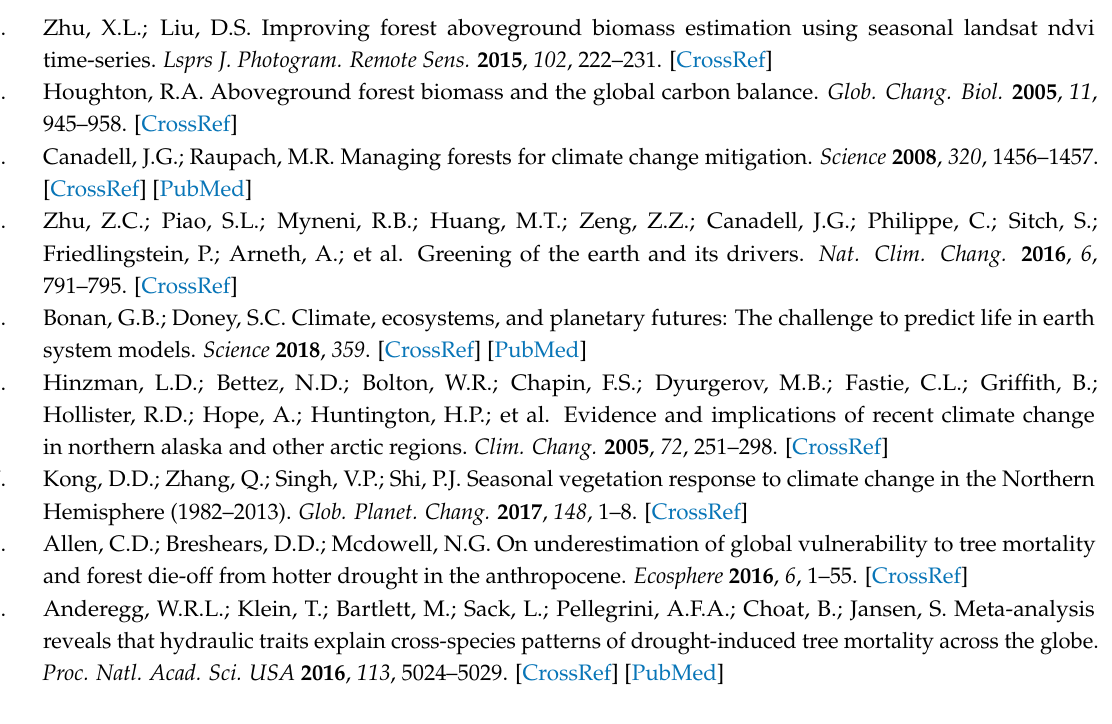
Figure S1: The spatial distribution (a) and interannual variability of regional mean PET (b) in northeastern China from 1982 to 2015, Figure S2: The linear trends of regional mean TEM (a–d), WD (e–h) and SR (i–l) in different seasons in northeastern China from 1982 to 2015. Shaded areas indicate the 95% confidence interval of the linear trends and k in y -axis is the slope of the linear fitting. The green points are the values of TEM, WD and SR, Figure S3: The distribution of linear trends of seasonal mean TEM (a–d), WD (e–h) and SR (i–l) along with MAI in different seasons over northeastern China. The red dashed lines is the line of MAI = 1.0 and MAI = 1.5, respectively, which means the thresholds for different drought regions, Table S1: The information of land cover classification in